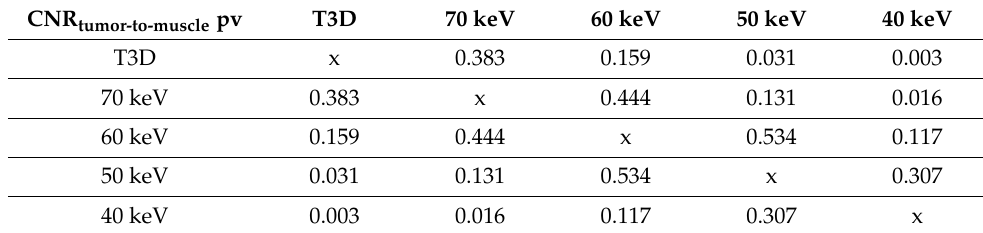
Table 14. Comparison of portal venous CNR tumor-to-muscle between T3D and low keV images. CNR tumor-to-muscle pv